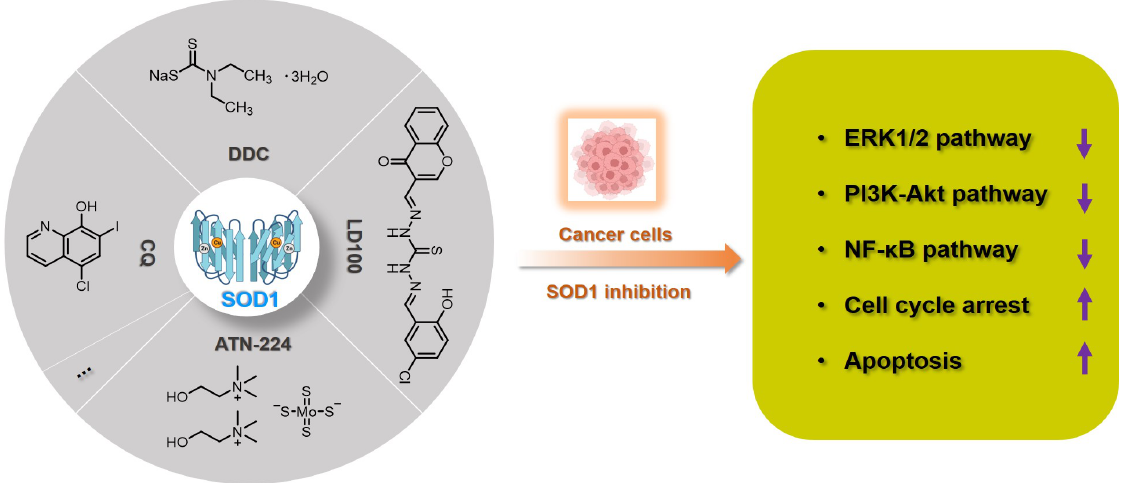
Figure 2. Summary of SOD1 inhibitors based on copper chelation. The specific activity inhibition of SOD1 selectively kills cancer cells by regulating the intracellular ROS signaling network.